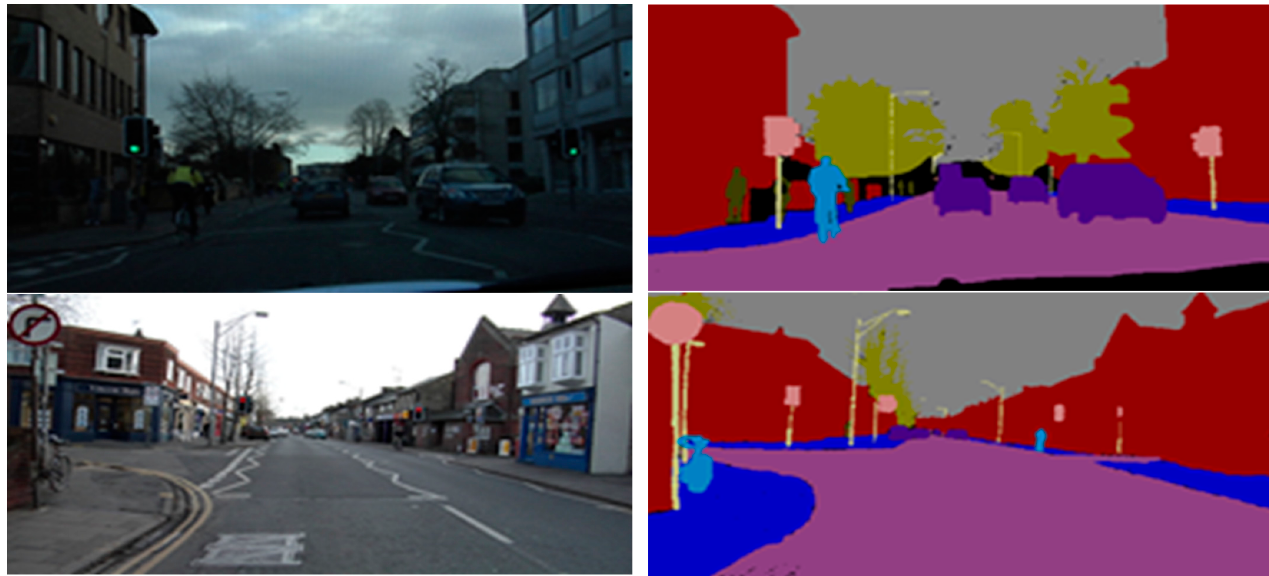
Figure 1. Examples of semantic segmentation applying pixel-wise classification, with the left column showing input images and the right column showing ground truth in which challenging factors, such as various classes and multi-scale objects, exist.